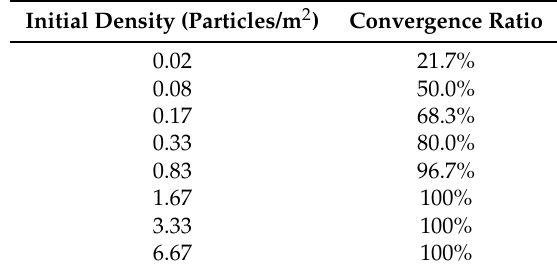
Table 1. Statistical results for the relocalization benchmark with an initial uncertainty area of 30 × 30 m 2 . Refer to Section 6.2.